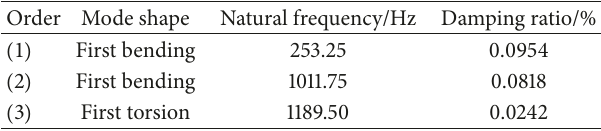
Table 4: Natural frequencies and modal damping ratio of the blade. Order Mode shape